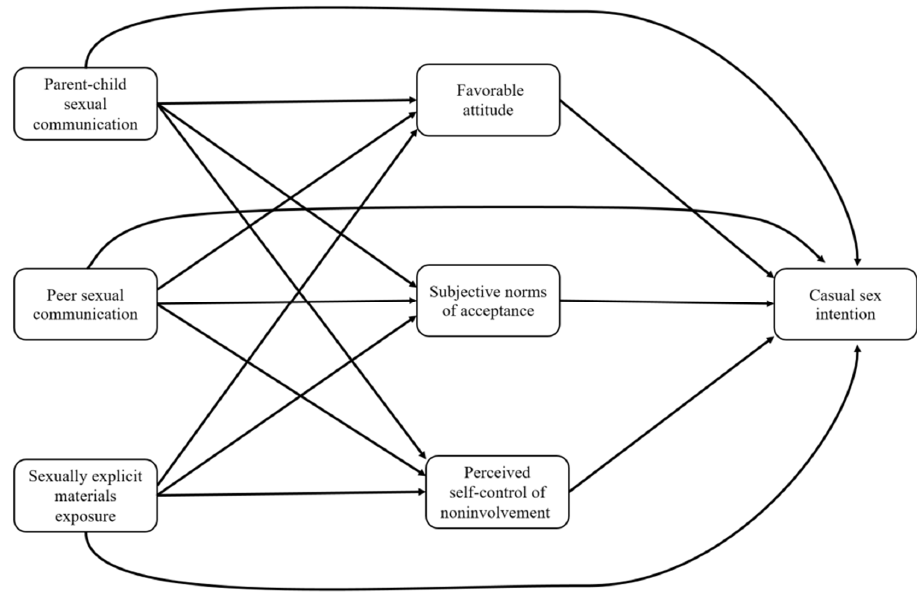
Figure 1. Proposed model in explaining intention to engage in casual